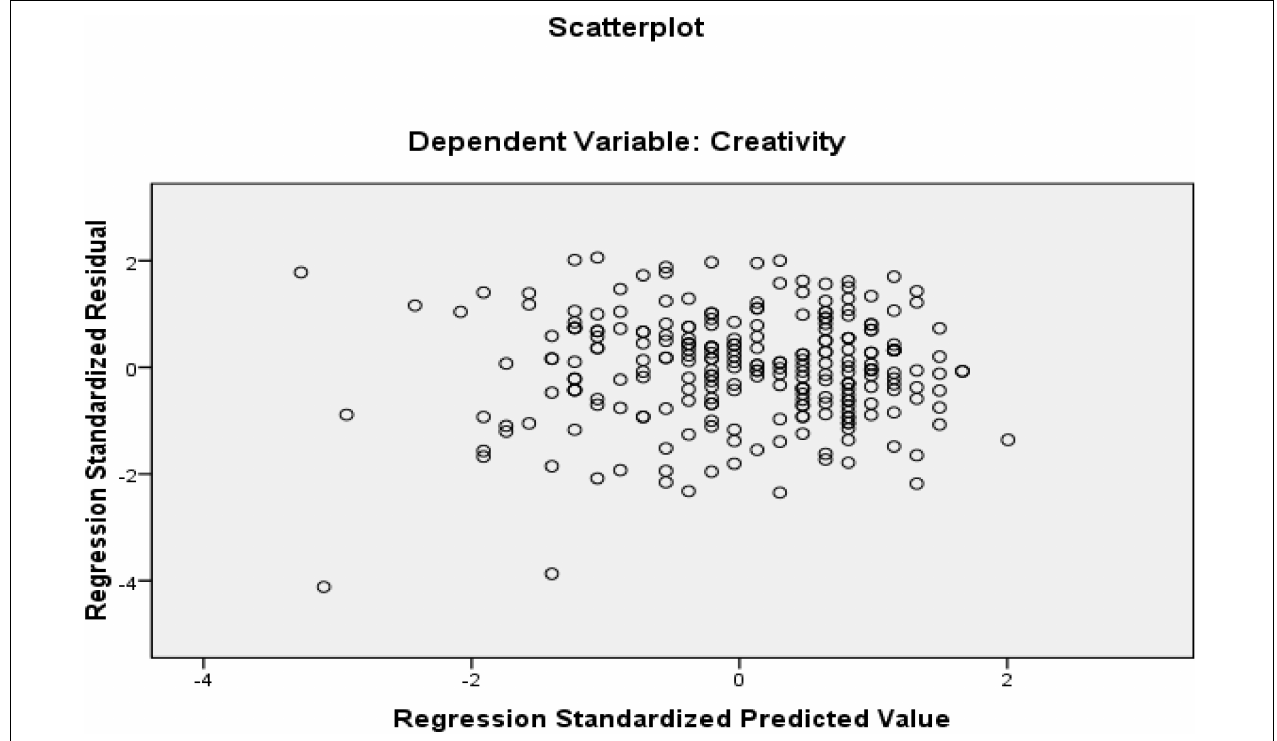
FIGURE 5 | Scatter plot of residuals (independent variable = resilience and dependent variable = creativity).